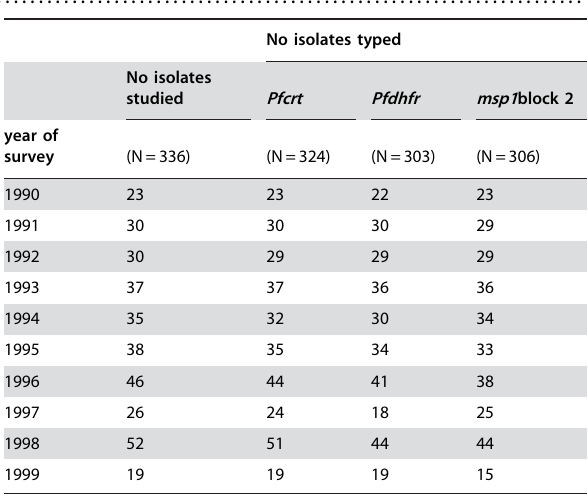
Table 1. Number of isolates studied by calendar year of survey and successfully typed by molecular beacons for the Pfcrt K76T and Pfdhfr-ts S108N loci and by nested PCR for